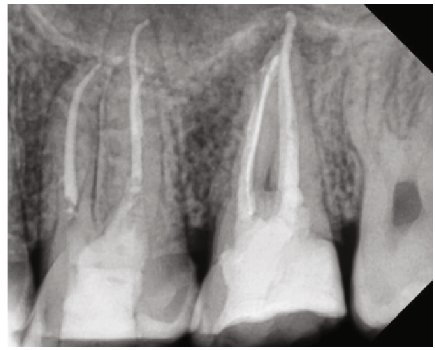
Figure 10: Periapical X-ray after 2 weeks of